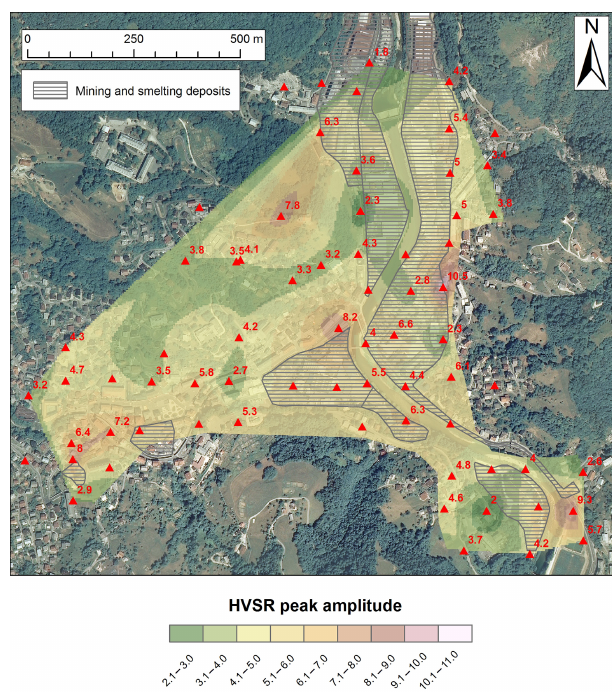
Figure 9. Map of microtremor HVSR peak amplitudes in the Idrija town area. Triangles indicate points of all measurements. Corre- sponding labels indicate the peak amplitudes for locations with suf- ficient HVSR response. Basemap is digital orthophoto